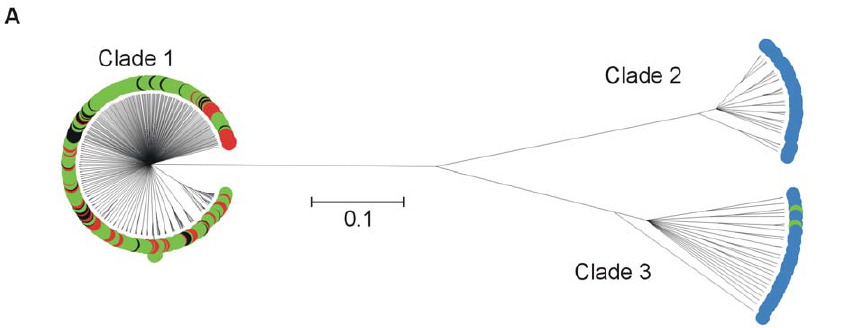
Figure 1. C LONAL F RAME genealogy of 7-locus MLST data from C.coli genotypes from clinical, animal faeces, food and environmental samples. STs from farm only (green), riparian only (blue), clinical only (red) and farm and clinical (black) sources are indicated by different